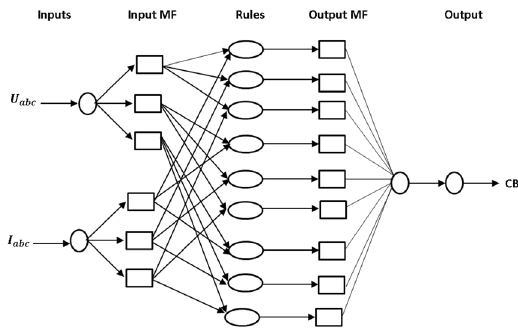
Fig. 4 Flowchart of classical outer crowbar protection technique using ANFIS